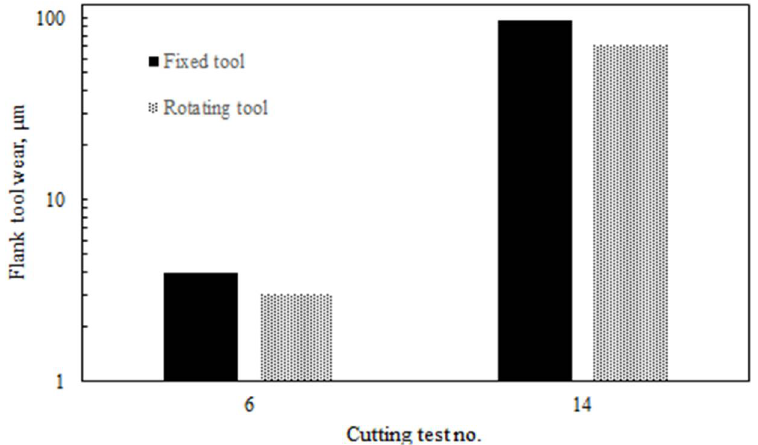
Figure 4. Tool wear results at worst and best scenarios for rotary tool versus fixed tool.